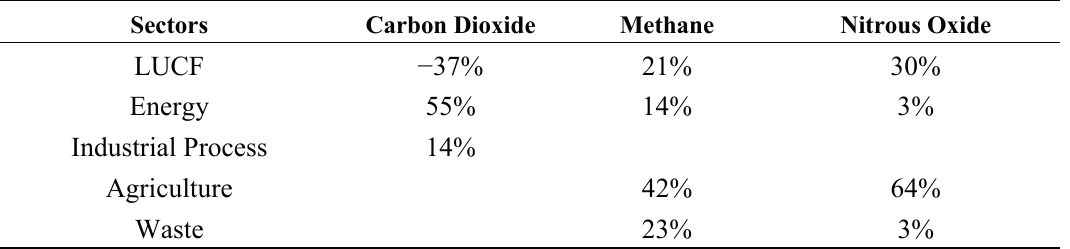
Figure A1. Cropping Systems in Ghana, Source: [23]. Table A1. Greenhouse gases emissions by gases. Source: Authors’ compilation from EPA